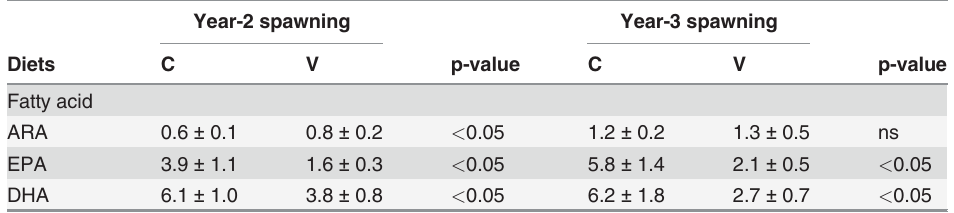
Table 7. ARA, EPA and DHA content (g/100g ova) in ova from second- and third-year